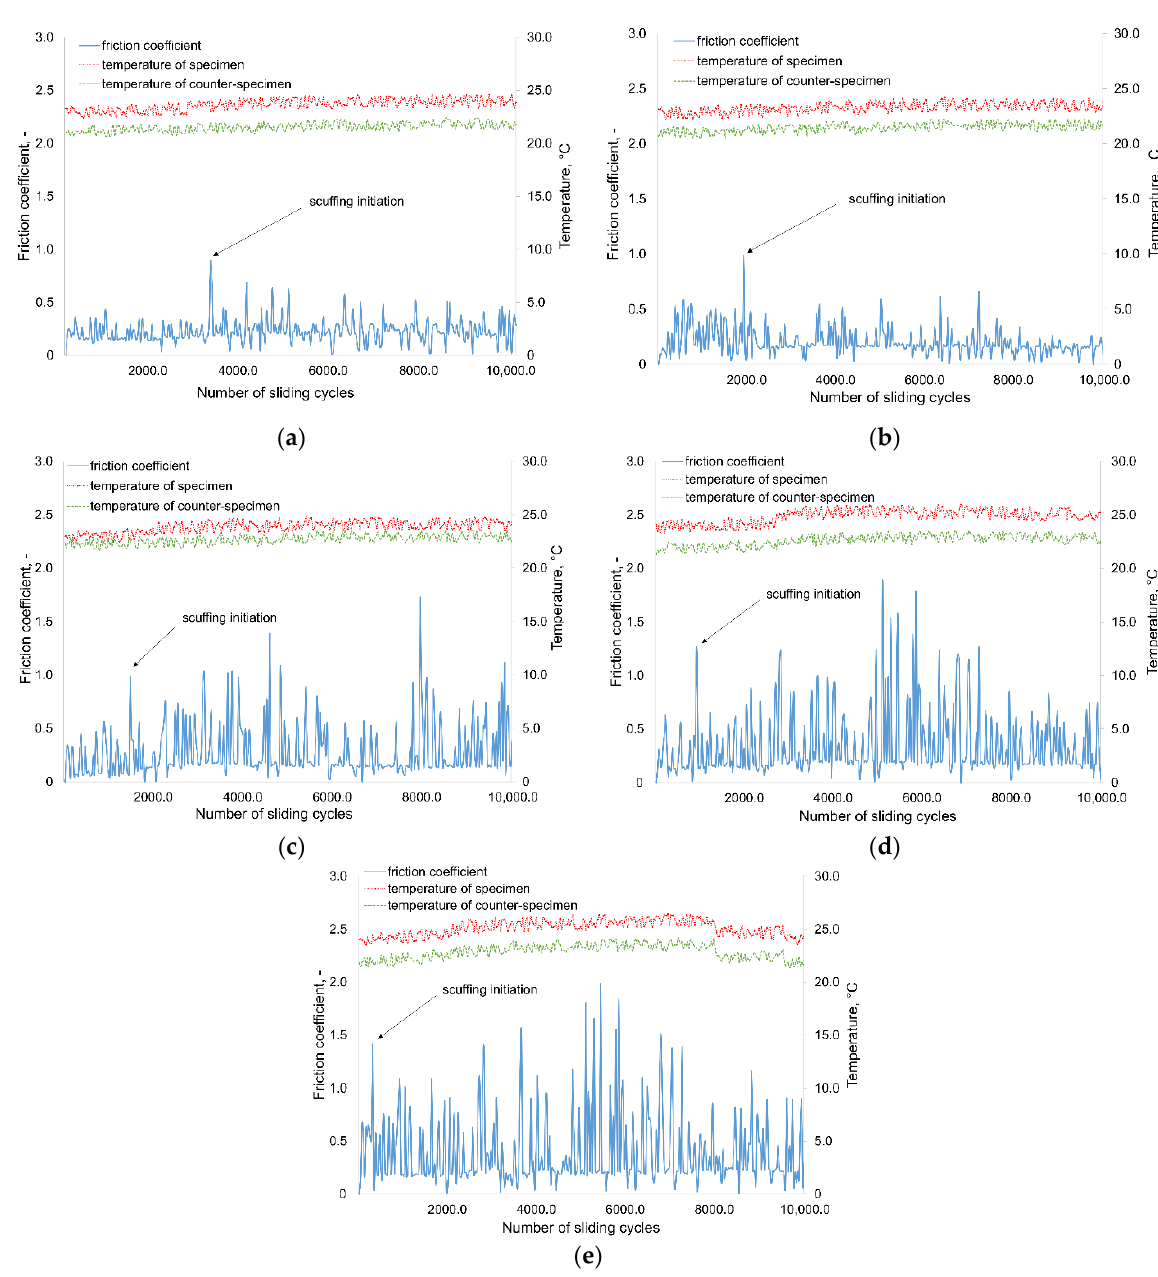
Figure 6. Results of the friction coefficient and temperature measurement for the example set: F = 0.1 N, α = 10°, f = 1 Hz and various value of f: (a) 1.0 Hz; (b) 2.0 Hz; (c) 5.0 Hz; (d) 7.5 H; (e) 10.0 Hz.